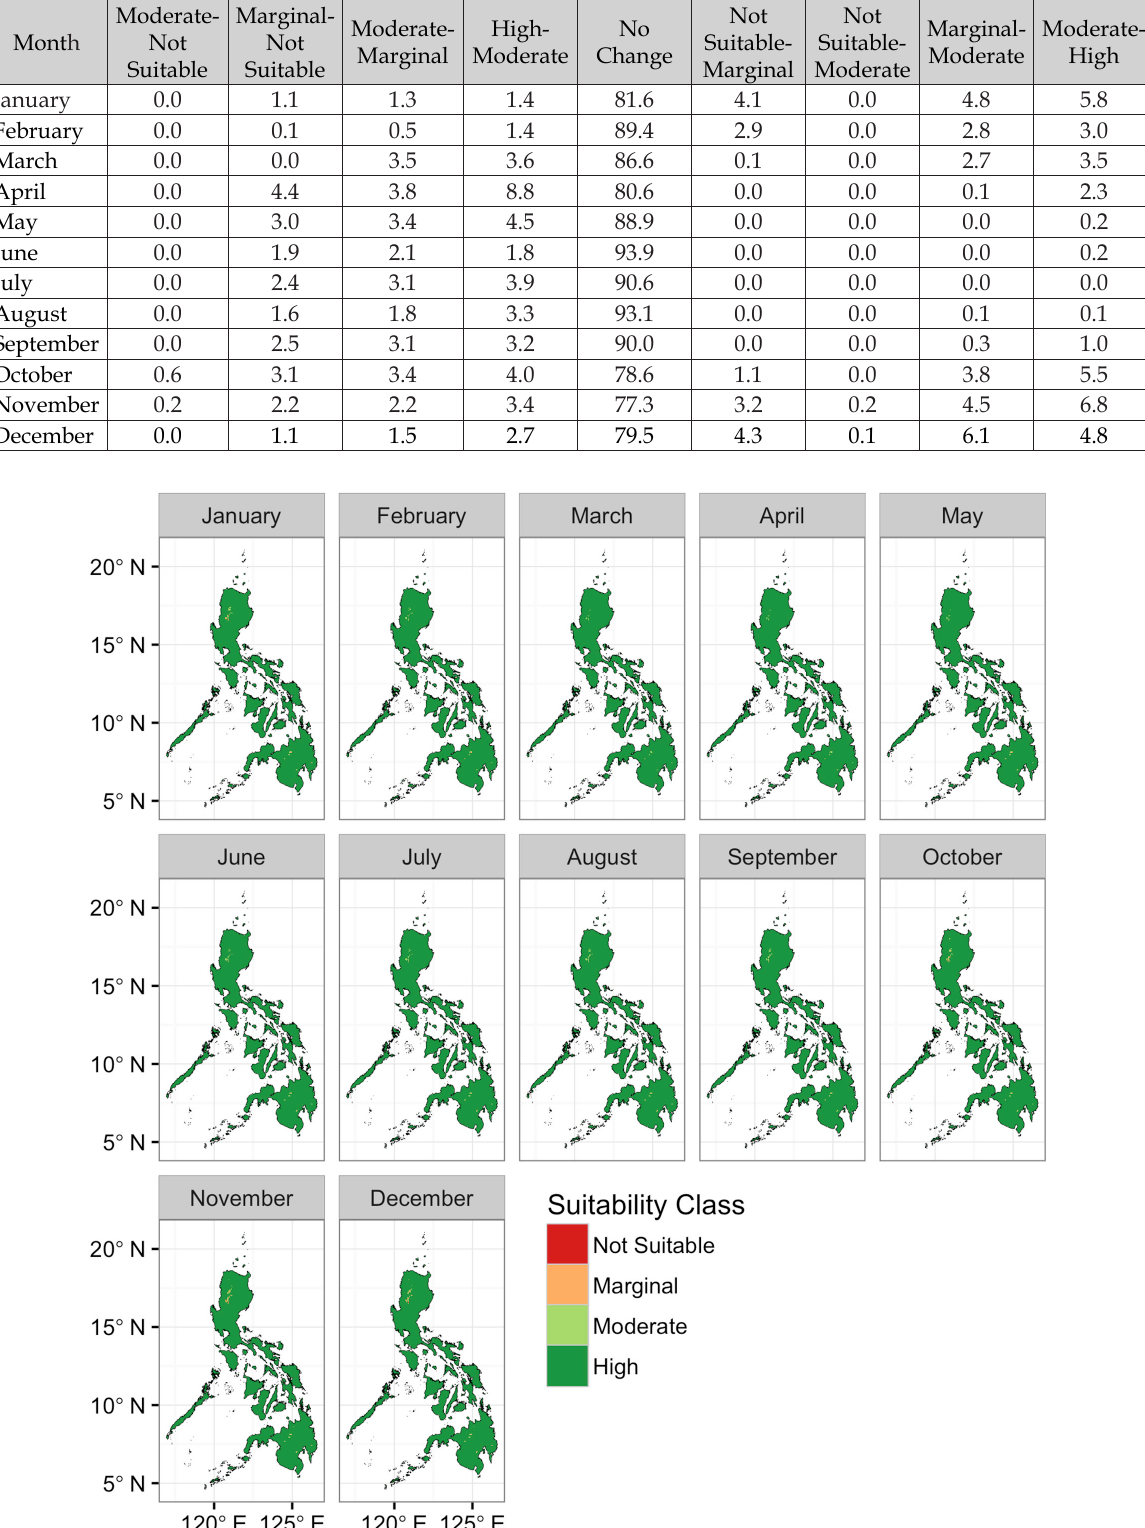
Fig. 10. Monthly spatial distribution of climatic suitability of corn based on temperature in the Philippines under baseline condition.